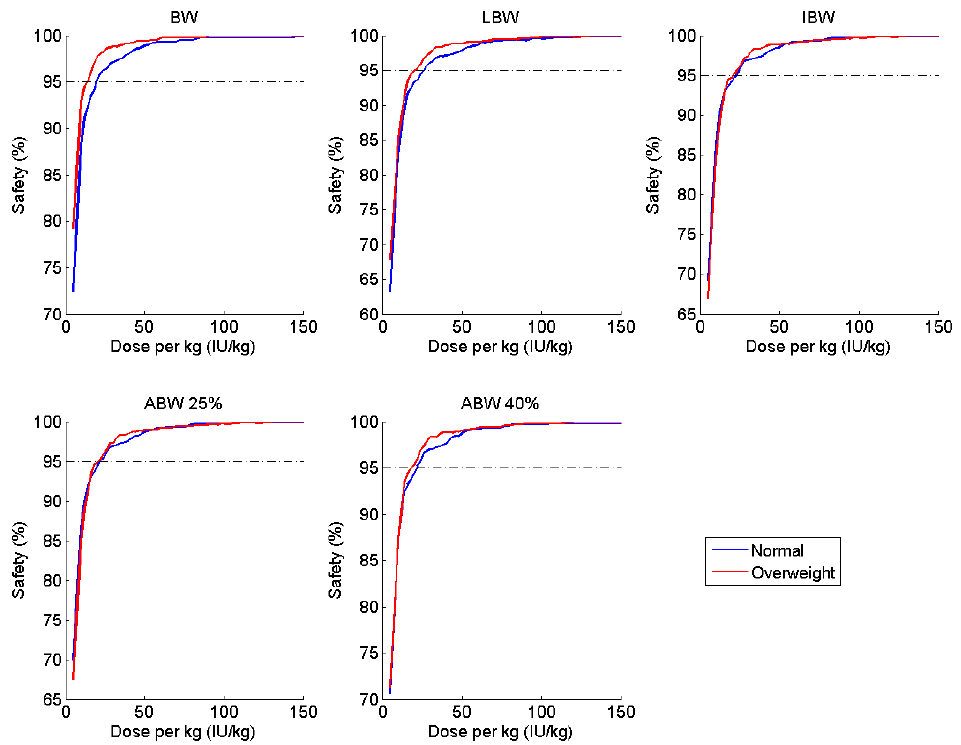
Figure 2. Percentage of patients with C min ≥ 1 IU dL − 1 (safety) at various doses per kg of various weight metrics, stratified by BMI subgroup, administered at 48-h intervals.